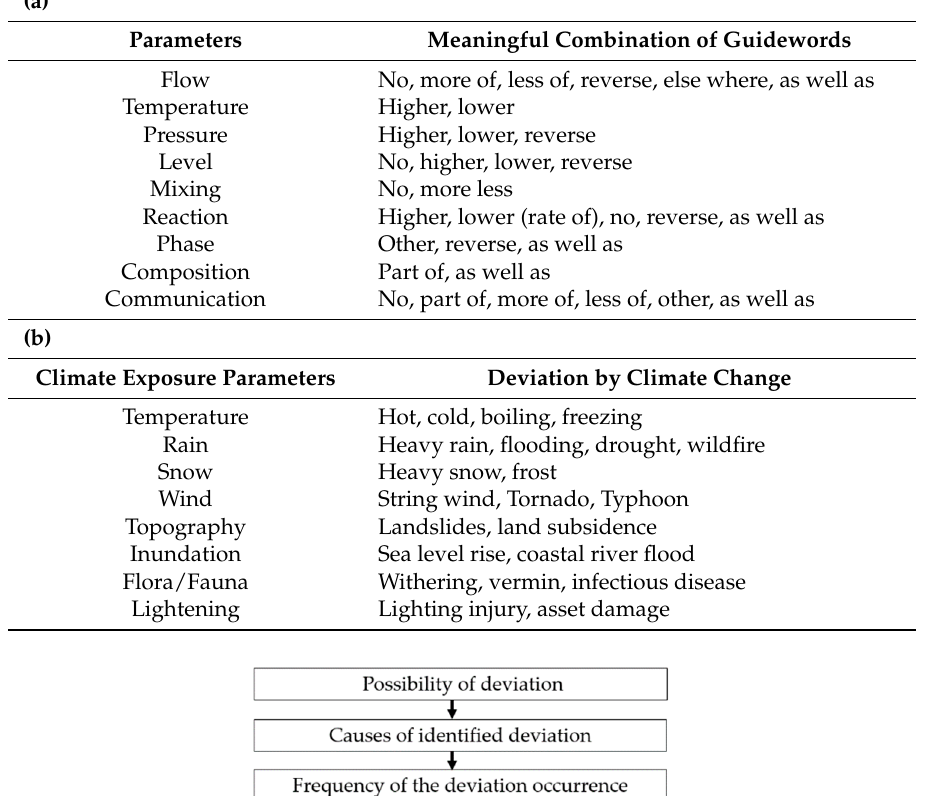
Table 1. ( a ) Meaningful combinations of guidewords for process parameters; ( b ) Deviations that lead to damage by natural hazards.